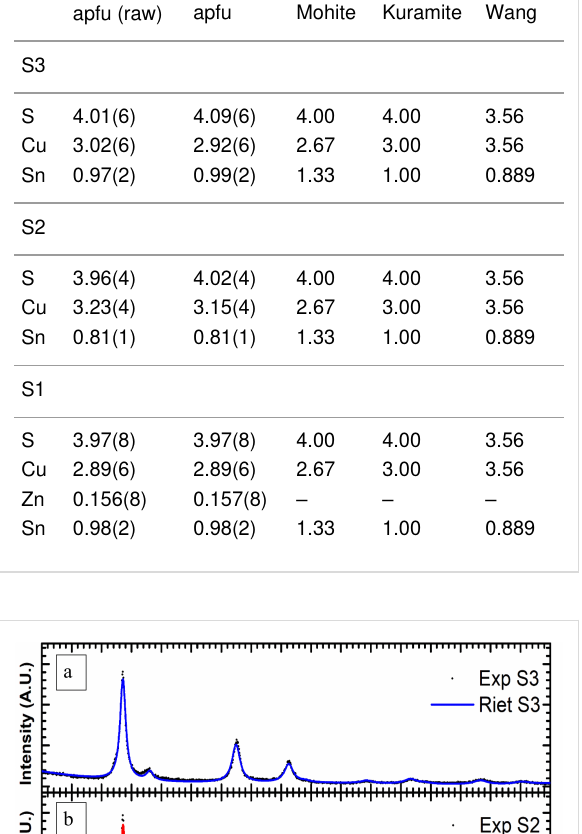
Table 3: Recalculated composition of samples S1, S2 and S3 after subtraction of the estimated amount of CuCl 2 . Comparison with the raw composition (apfu (atoms per formula unit) (raw)) and the compo- sition of the statistically close phases.